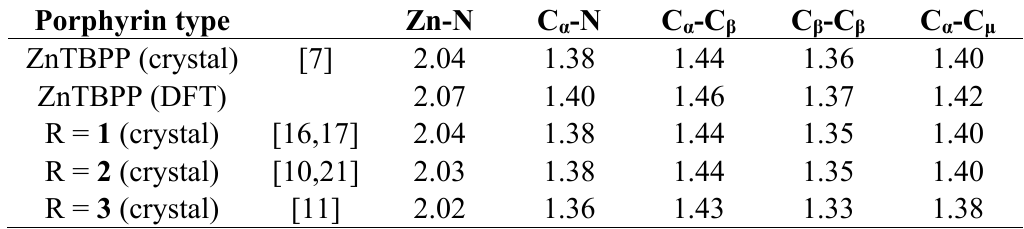
Table 1. Average interatomic distances within the pyrrole subunit, meso -bridges and Zn-N for the model compound ZnTBPP (R = 1, X = tBu) and diverse zinc porphyrin molecules (acc. to Figure 1); "crystal" applies to values calculated from real crystallographic data reported elsewhere and "DFT" refers to theoretical results obtained in this work. For R = 1 the data represent average values of 105 diverse molecules analyzed.